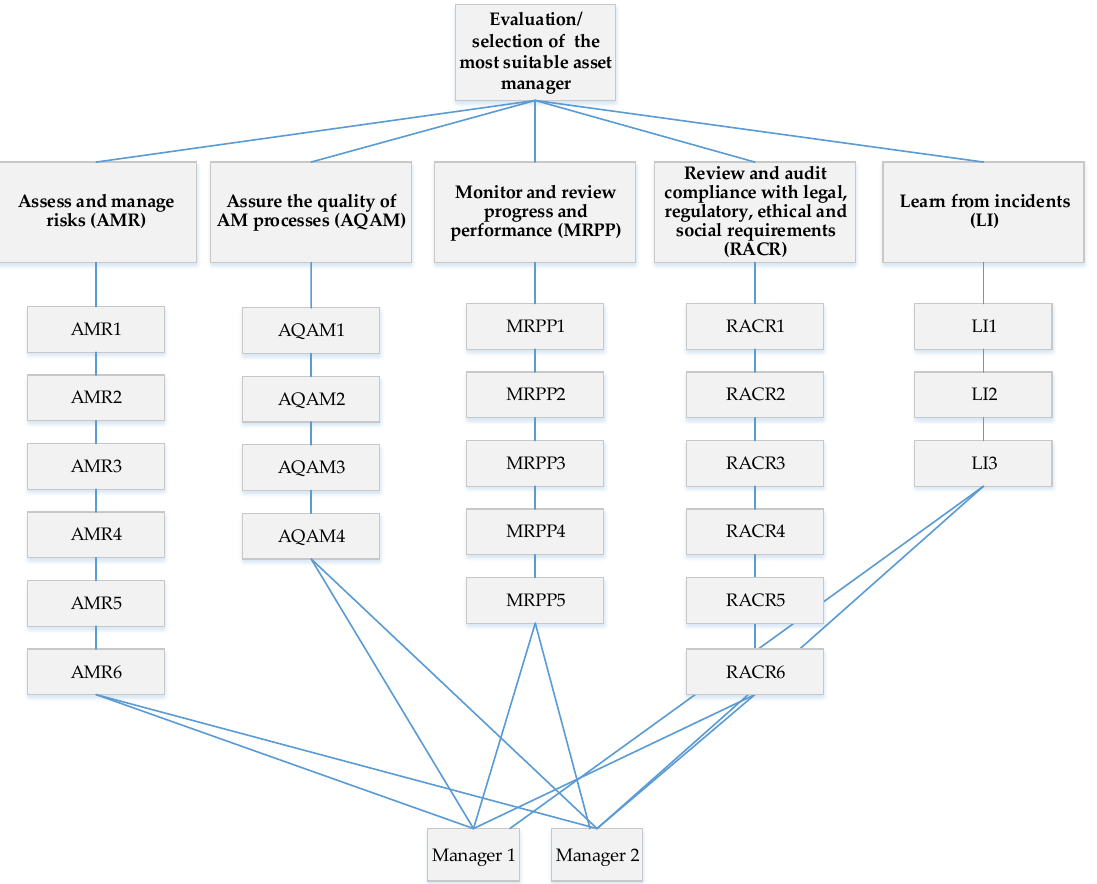
Figure 2. A hierarchy model for asset manager